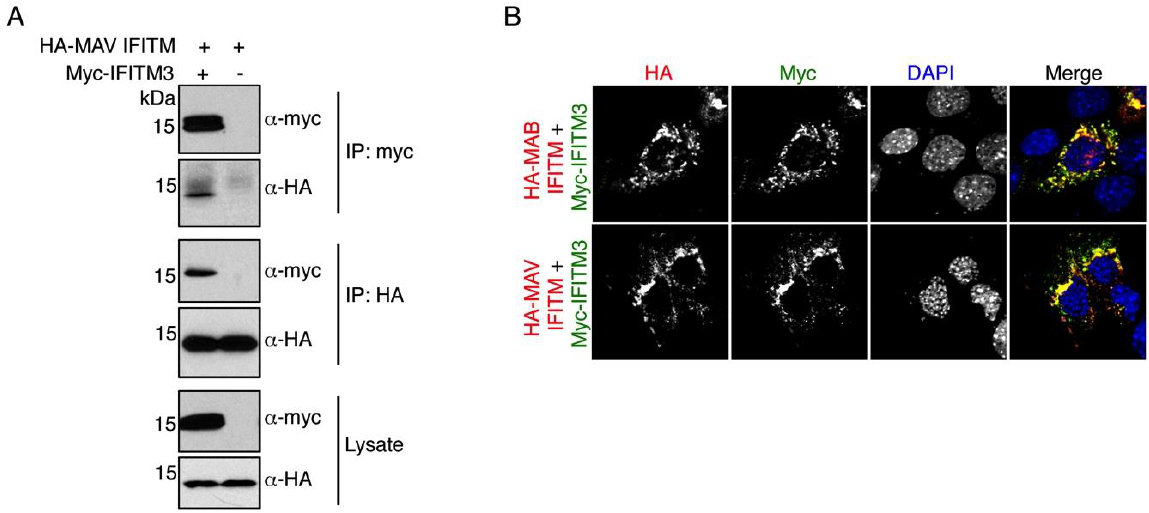
Figure 5. Figure 5. MAV IFITM co-immunoprecipitates and co-localizes with IFITM3. ( A , B ) HEK293T cells were transfected with the indicated constructs expressing HA-tagged mycobacterial IFITMs and human myc-IFITM3. ( A ) Cells were lysed and portions of the cell lysates were subjected to immunoprecipitation with either anti-HA or anti-myc Affinity Gel prior to SDS-PAGE and Western blot analysis with anti-HA or anti-myc antibodies. Western blotting of the cell lysates confirmed the equal input amounts of HA-MAV IFITM and the presence of myc-IFITM3; ( B ) Confocal microscopy imaging of mycobacterial IFITMs with myc-IFITM3 demonstrated their co-localization in cells. Anti-HA staining provided visualization of the mycobacterial IFITMs while anti-myc staining allowed visualization of IFITM3. DAPI staining was used to visualize nuclei. Merged images are shown with yellow regions indicating overlap between mycobacterial IFITMs and IFITM3.